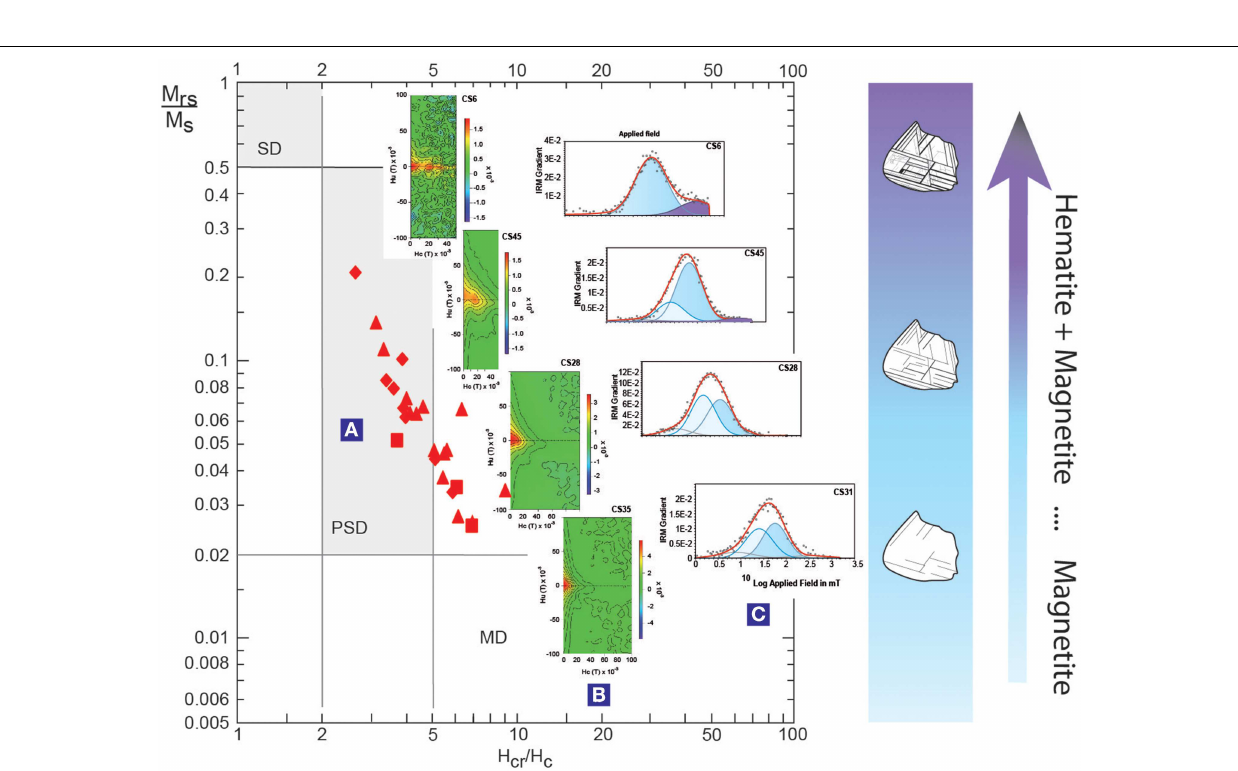
FIGURE 4 | Variation of low-field magnetic susceptibility during a heating-cooling cycle (red and blue lines, respectively).